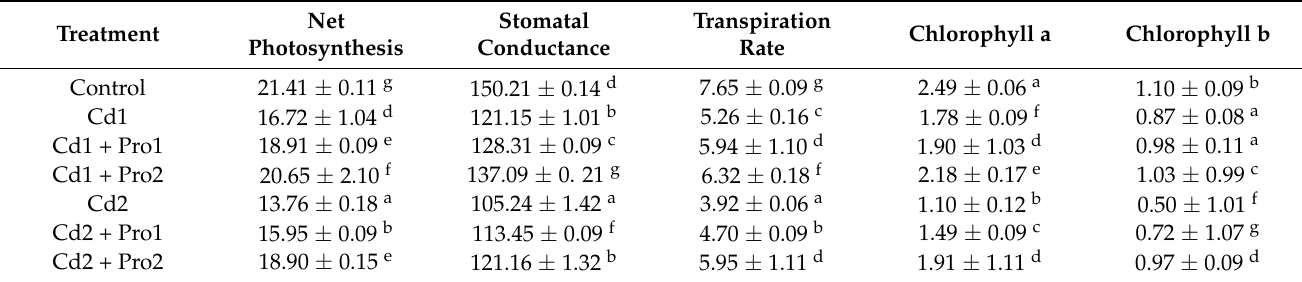
Values represent the means of three replicates ± SD. Cd 1 (4 mg), Cd 2 (8 mg), Cd 1 + Pro 1 (4 mg Cd + 3 mM proline), Cd 1 + Pro 2 (4 mg Cd + 6 mM proline), Cd 2 + Pro 1 (8 mg Cd + 3 mM proline), Cd 2 + Pro 2 (8 mg Cd + 6 mM proline). Different small letters in columns show significant differences and the same small letters show non-significant difference ( p ≤ 0.05) according to Duncan’s multiple range